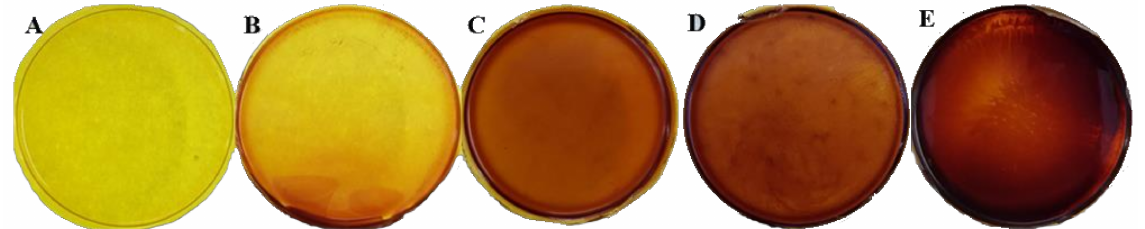
Figure 7. Pristine PIM-1 membrane ( A ), PIM1-ABT01 (3 wt %) ( B ), PIM-ABT02 (3 wt %) ( C ), PIM1-ABT01 (10 wt %) ( D ) and PIM1-ABT02 (10 wt %) ( E